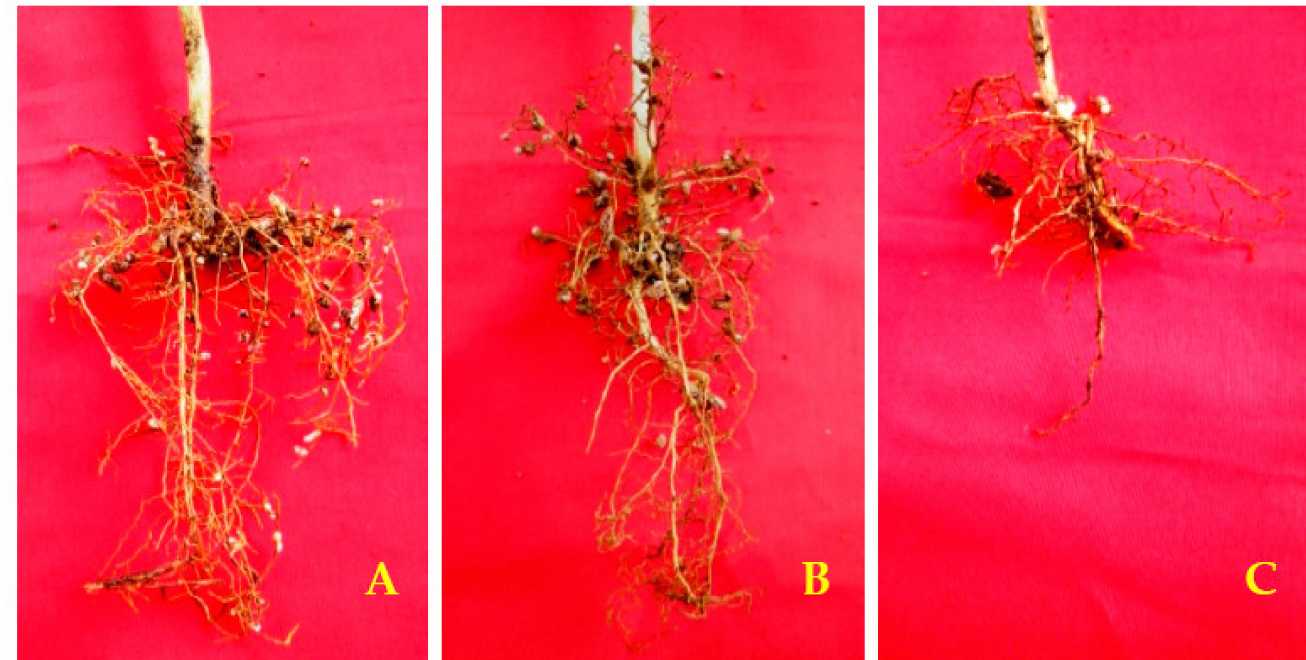
Figure 6. Visualization of root nodules of P. mooniana plant mycorrhizal ( A , B ) and non-mycorrhizal ( C )